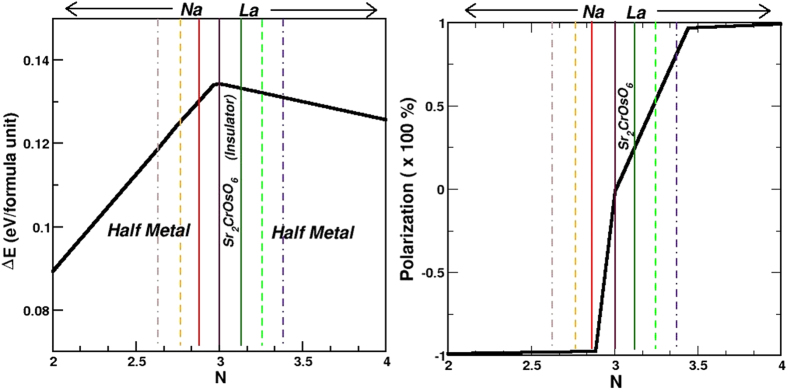
Left panel: The energy difference between PM and FM arrangement of Cr spins, plotted as a function of the valence electron count of Os ion, shown as black solid line.The vertical lines mark the filling corresponding to the parent (solid, magenta) and various Na (red-solid, orange-dashed and brown-dot-dashed for Sr1.875Na0.125CrOsO6, Sr1.75Na0.25CrOsO6, Sr1.625Na0.375CrOsO6, respectively) and La doped compounds (green-solid, green-dashed and indigo-dot-dashed for Sr1.875La0.125CrOsO6, Sr1.75La0.25CrOsO6, Sr1.625La0.375CrOsO6, respectively) studied in present work. Both the Na-doped and La-doped compounds are half-metallic, while the parent compound with electron count of three, is insulating. Right panel: The spin polarization plotted as a function of the electron occupancy of Os ion. The vertical lines mark the parent and various Na and La doped compounds as in left panel.